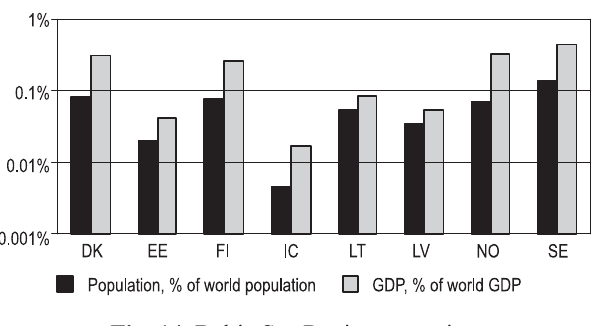
Fig. 14 . Baltic Sea Region countries: human resources and